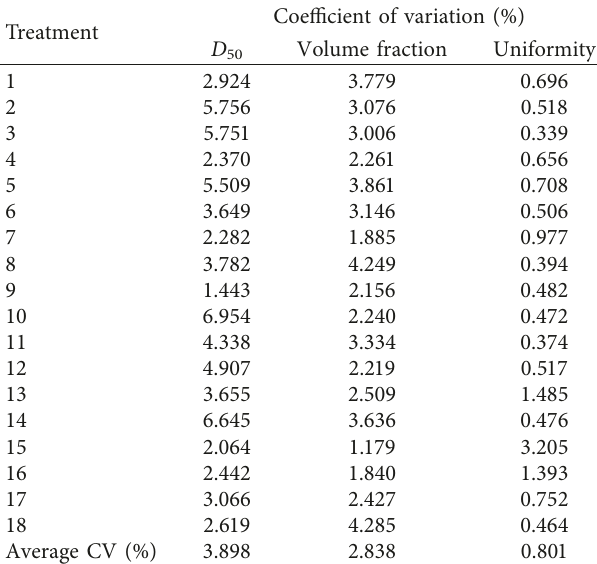
Table 5: Precision of responses for the spray-drying